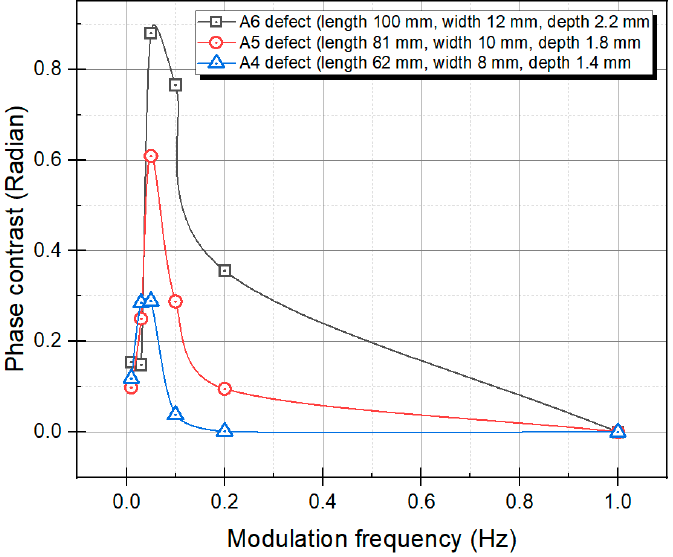
Figure 13. Phase contrast trend according to modulation frequency by HA.